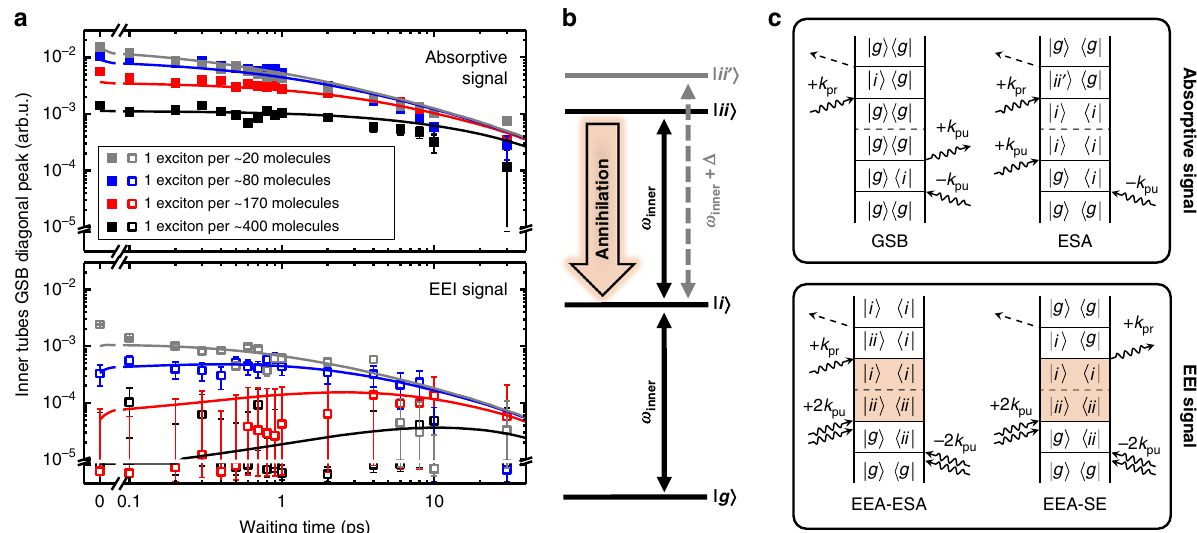
Fig. 3 Absorptive and EEI transients of isolated inner tubes. a Log – log plot of the absorptive (upper panel, solid squares) and EEI (lower panel, open squares) GSB/SE transients for isolated inner tubes for different exciton densities. The transients were obtained by integrating the signal in the rectangular regions of interest shown in Fig. 2c; the panels are drawn with the same scaling to emphasize their direct comparability, which is one of the constraints in the Monte Carlo simulations ( vide infra ). The sign of the EEI responses was inverted for the ease of comparison. The error bars refer to the detection noise level in the experiment (Supplementary Note 3). The solid lines depict the results from Monte Carlo simulations of the exciton dynamics on isolated inner tubes. The amplitude (vertical) scaling between experimental and simulated data is preserved, i.e., for each signal (absorptive and EEI) a single scaling factor was used for all simulated transients. b Energy level diagram of the isolated inner nanotubes with the electronic ground state (| g 〉 ) and the one- (| i 〉 ) and bi-exciton (| ii 〉 ) states ( i stands for the i nner tube). Optical transitions are marked by vertical black arrows with the corresponding frequency ω inner . The blue-shifted one- to two-exciton transition within the same excited domain (| ii ’ 〉 , dashed gray arrow; refs. 47,48 ) is shown for comparison. Bold arrow: annihilation channel from the bi-excitonic state. c Representative set of rephasing double-sided Feynman diagrams, which contribute to the absorptive ( ω inner → ω inner ; upper panel) and EEI (2 ω inner → ω inner ; bottom panel) diagonal peaks of isolated inner tubes. In the diagrams time fl ows from the bottom to the top during which the interactions with the laser pulses are indicated by arrows. The dashed line indicates propagation during the waiting time T . The double interaction with each of the two pump pulses can create a population of the ground state, a one-exciton state or a bi-exciton state, which are subsequently probed by GSB (| g 〉 → | i 〉 ), SE (| i 〉 → | g 〉 or | ii 〉 → | i 〉 ) or ESA (| i 〉 → | ii 〉 or | i 〉 → | ii' 〉 ). The process of exciton – exciton annihilation (EEA) is shaded in